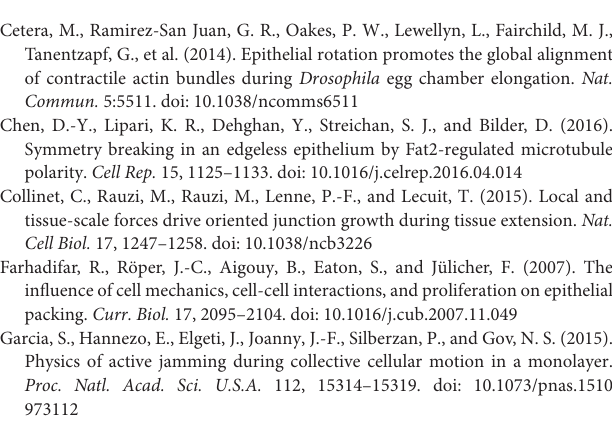
Supplementary Figure 1 | Schematic explanation of spatiotemporal correlation function. Supplementary Movie 1 | Numerical simulation of the vertex model without tension fluctuations corresponding to Figure 3 . Supplementary Movie 2 | Numerical simulation of the vertex model with tension fluctuations corresponding to Figure 8